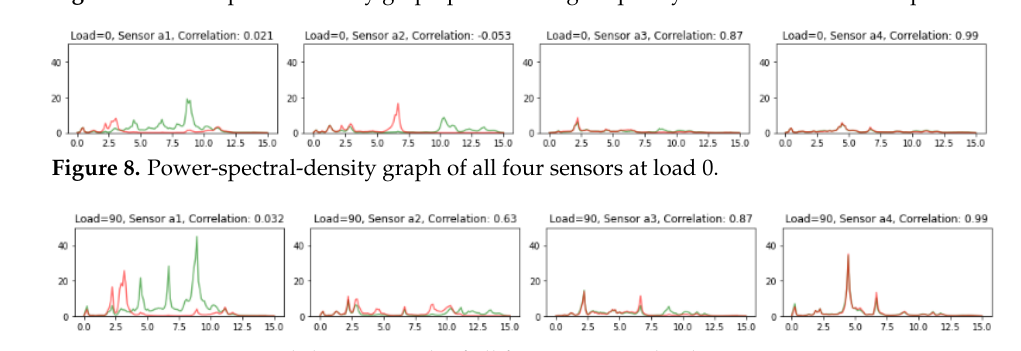
Figure 7. Power-spectral-density graph plotted using frequency values of the data samples.